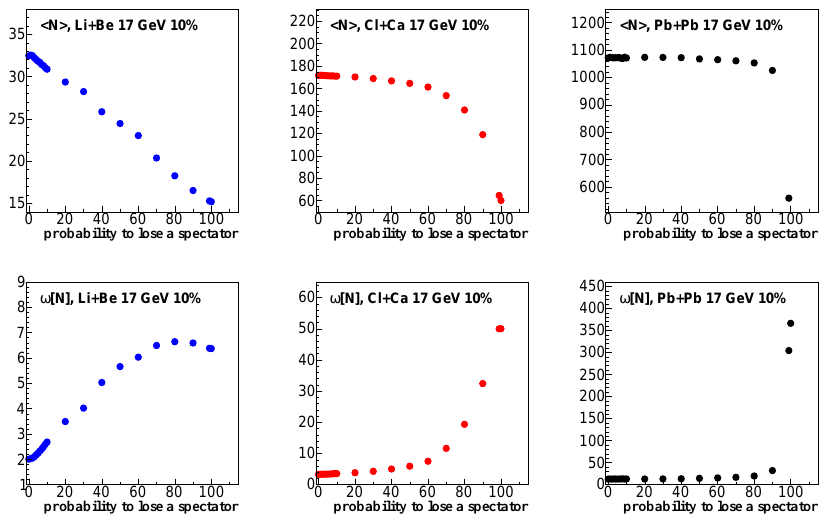
Figure 5. Multiplicity and scaled variance versus the probability to lose a forward spectator in WNM with a centrality selection based on the number of detected forward